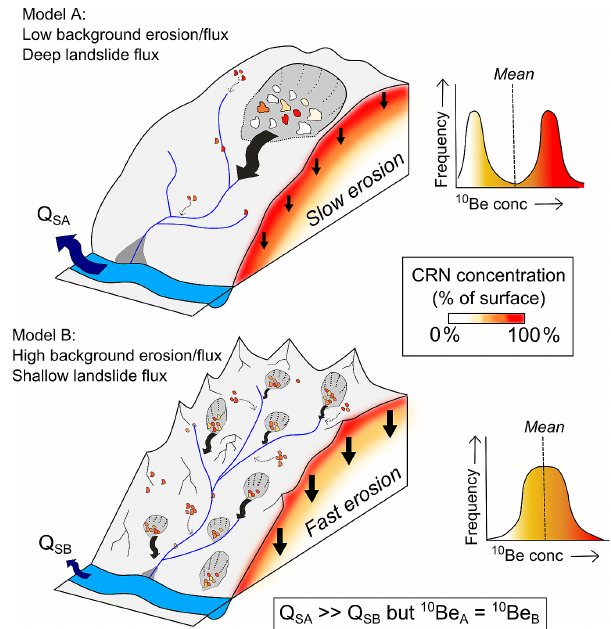
Figure 13. Schematic of how comparable mean CRN concentra- tions in river sand can be derived under two different end-member erosion scenarios with different volumetric sediment fluxes. In these instances, slow background erosion rates and deep landslid- ing (Model A) result in comparable CRN concentrations to land- scapes dominated by faster background erosion rates and shallow landsliding (Model B). If Model A is set with a background ero- sion rate of 0.4mmyr − 1 and 5m deep landsliding over 0.5% of the catchment, and Model B with 2mmyr − 1 background erosion rates and 1m deep landsliding (over the same area), comparable CRN concentrations (see black dots marked in Fig. 8a) and CRN-derived sediment fluxes are generated, but volumetric sediment fluxes are over 3 times larger in Model A. This is due to the relative enrich- ment of 10 Be in the upper 2m of the landscape with low background erosion rates, which when combined with low CRN concentration material from depth, results in two distinct CRN concentration pop- ulations. Where erosion is generally more homogeneous (Model B) and CRN concentrations are distributed more uniformly, compara- ble mean CRN concentrations are derived between the two mod- els. Both scenarios assume complete mixing of the event sediment, hence why these are considered end-member or extreme